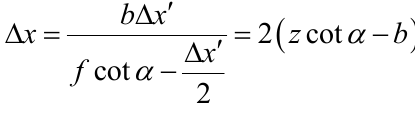
Figure 6. Detectable range about the x